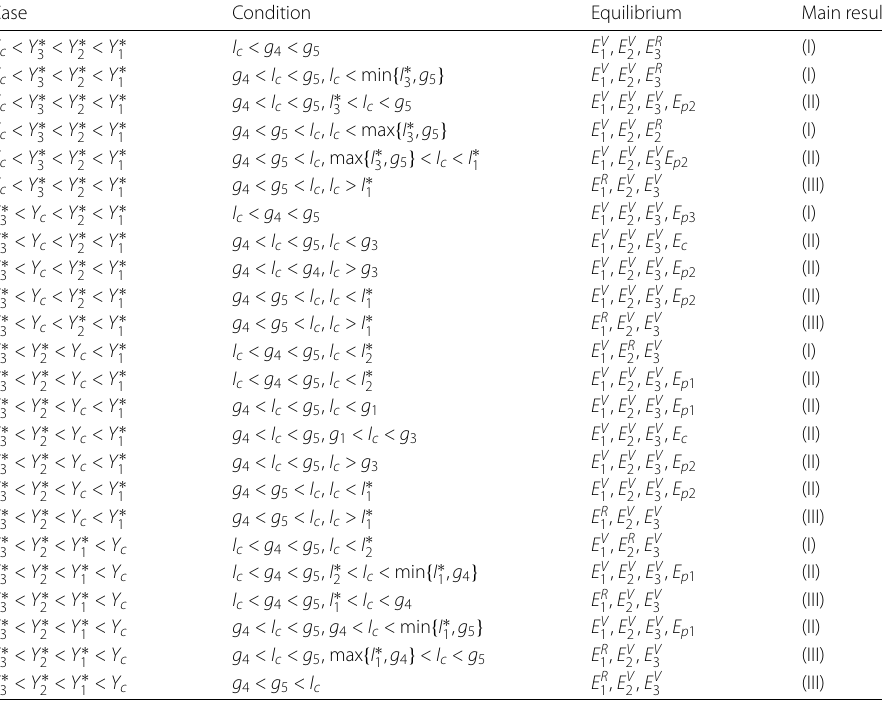
Table 1 Global dynamics of system (1) with (2) summarized from Sects. 3, 4, 5 and 6 Case Condition Equilibrium Main